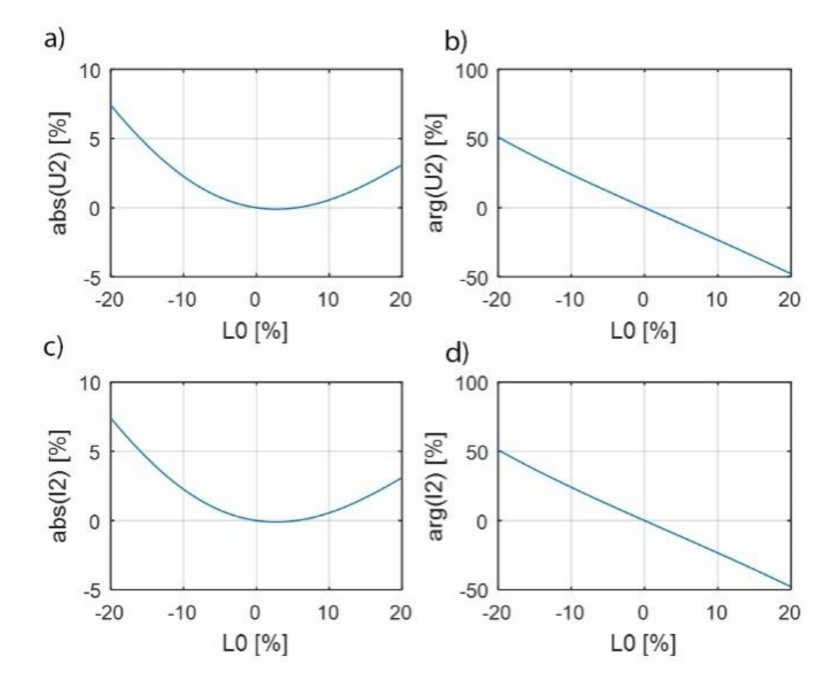
Figure 17. Changes of wave parameters depending on L 0 at f = 100 kHz; ( a ) U 2 voltage modulus, ( b ) U 2 argument, ( c ) I 2 modulus, ( d ) I 2 argument.